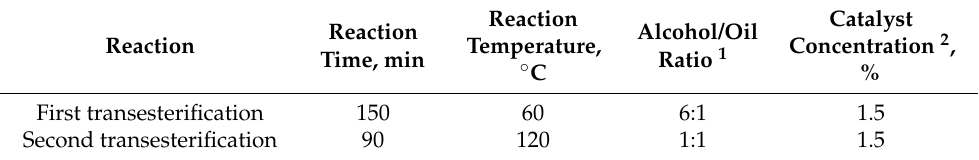
Table 1. Transesterification conditions for biolubricant